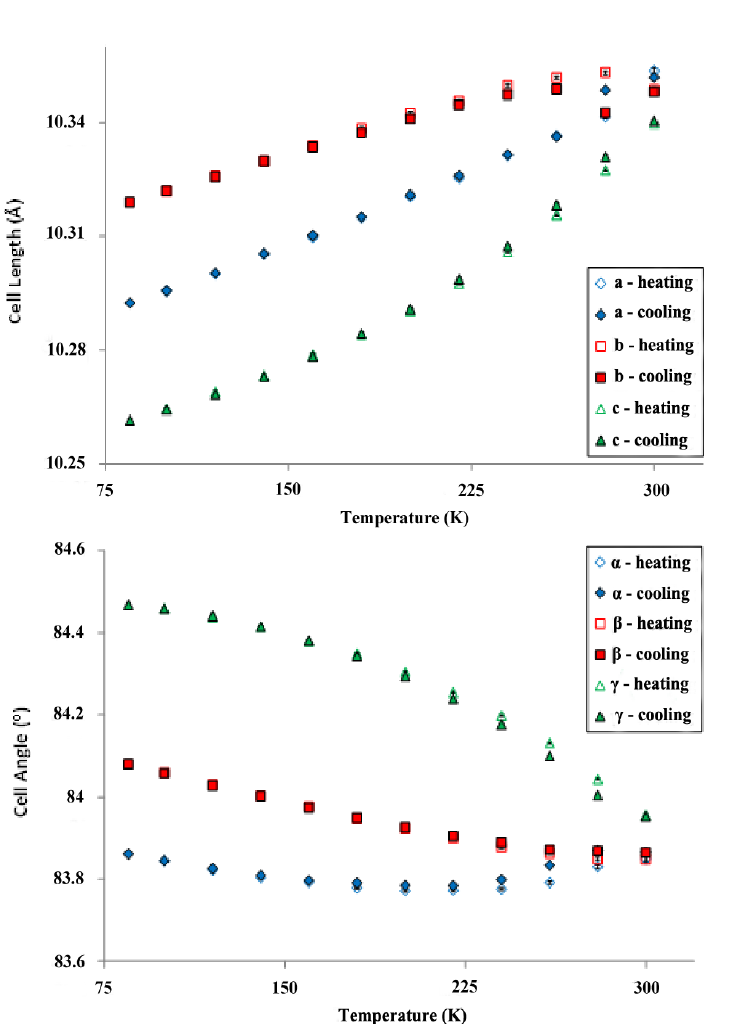
Figure 8. Lattice parameters derived from SXPD data for Rb 2 TiCu 3 F 12 powder as a function of temperature (error bars